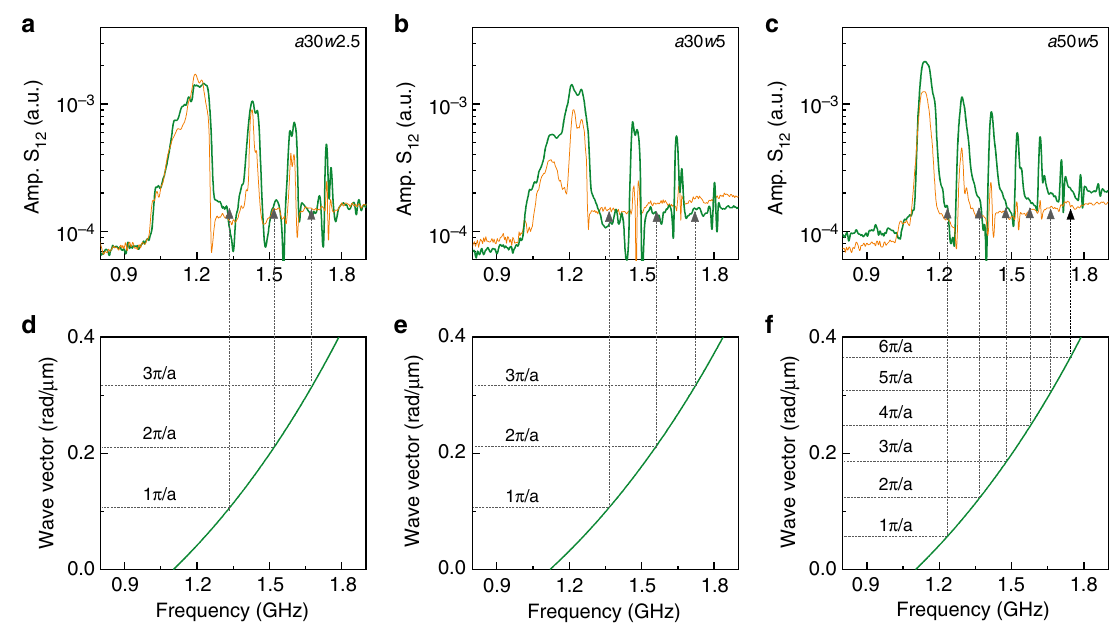
Fig. 3 Spin-wave dispersion relations and Bragg re fl ection. a – c Transmission spectra of CoFeB/YIG bicomponent magnonic crystals (green lines) and YIG stripes with airgaps (orange lines). The magnonic crystals consist of N = 4 grooves. The lattice constants and groove widths are indicated in the graphs. d – f Calculated dispersion relations of DE spin waves for the bicomponent magnonic crystals. The vertical and horizontal dashed lines show the center frequencies of bandgaps and corresponding wave vectors